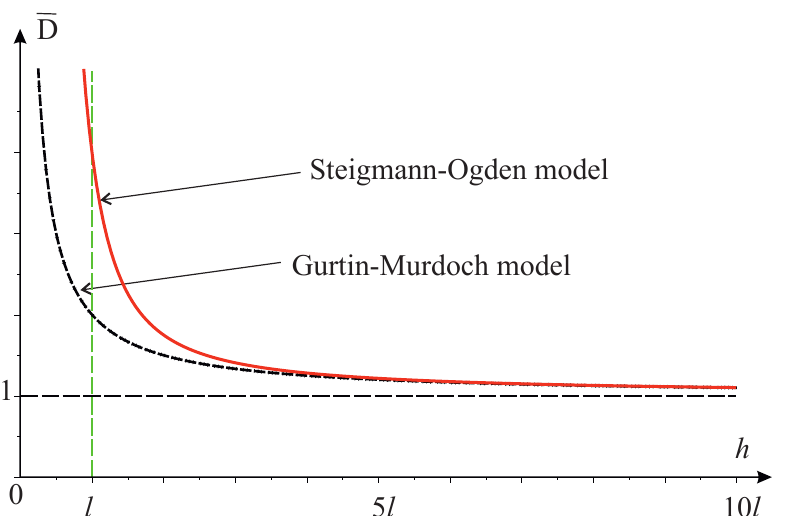
Figure 2. Dimensionless bending stiffness D = D eff / D vs. thickness h (solid red curve). The dashed blue curve corresponds to the Gurtin–Murdoch model; the horizonal dashed black line describes the classic bending stiffness. Finally, the vertical dashed green line marks the characteristic length l defined as l = ( λ S + 2 µ ) h 2 / D